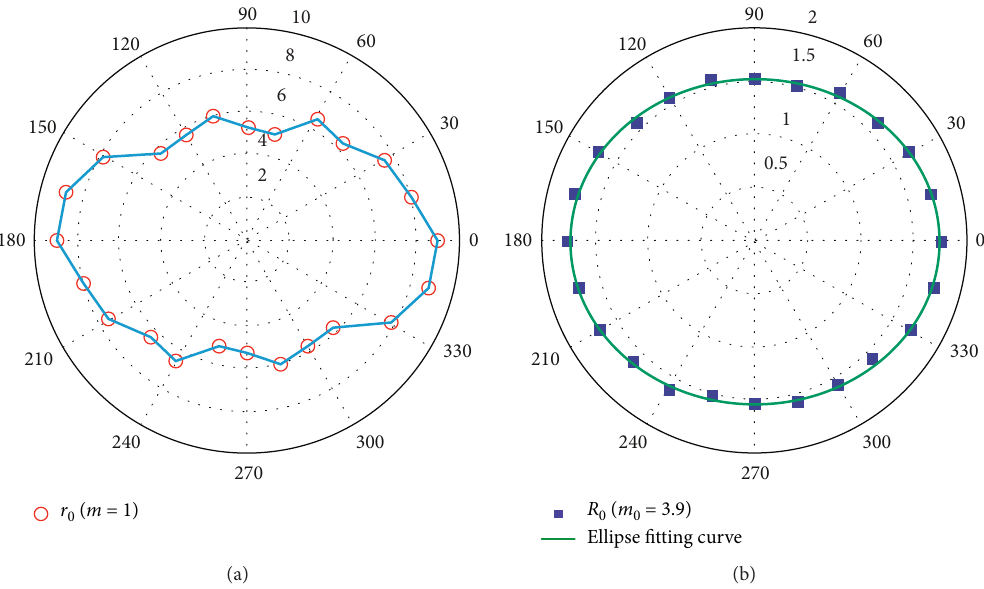
Figure 7: Polar plots of the original and processed JRC values and the ellipse fitting curves of the test samples in the length of